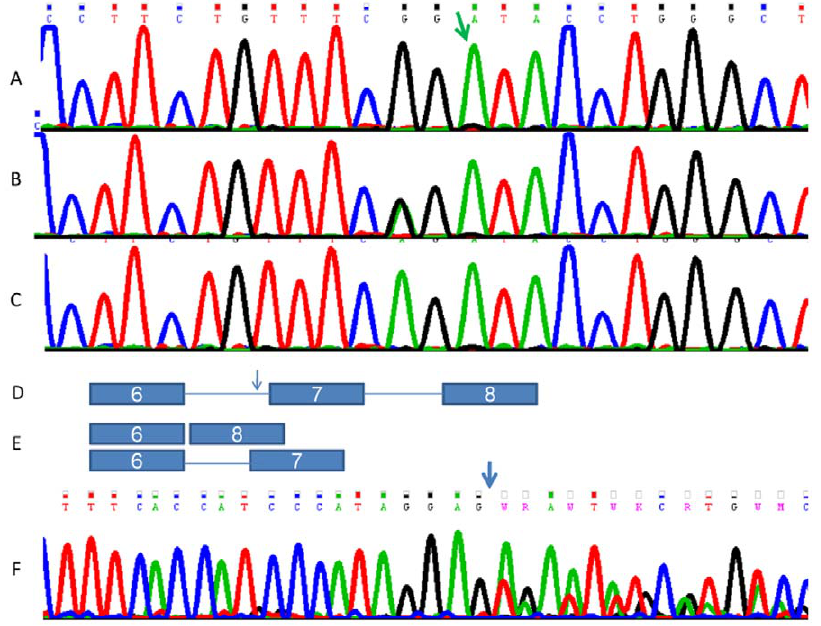
Figure 1. The c.801 2 2 A 2. G mutation in the DNAJC6 gene. The green arrow points at the first nucleotide of exon 7 and the mutation affects the preceding AG splice acceptor site of intron 6 which is changed to GG in the patient (A). The sequence of an obligate heterozygote is shown in (B) and that of a control in (C). Schematic representation of the mutation site at the genomic level (D) and its impact on the cDNA (E). Chromatogram of cDNA from a patient encompassing the 3 9 junction of exon 6 (F) and demonstrating a transcript lacking exon 7 and another transcript where nNext to the last base of exon 6 (blue arrow) overlapping exon 8 sequence is the intronic sequences from intron 6 (c.801 2 91). The normal exon 6/exon 7 spliced form is